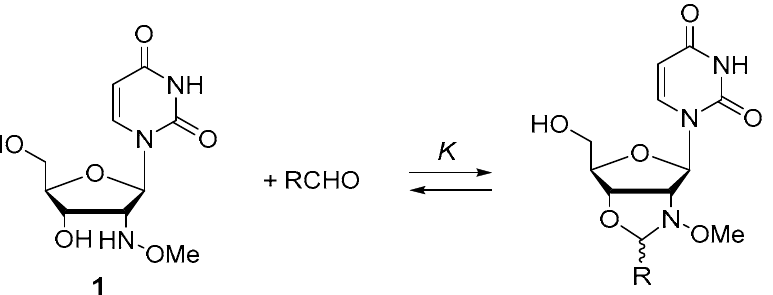
Figure 1. Formation of N- (methoxy)oxazolidines between 2 ′ -deoxy-2 ′ -( N -methoxyamino) uridine and small molecule aldehydes (R = cf. Table 2).